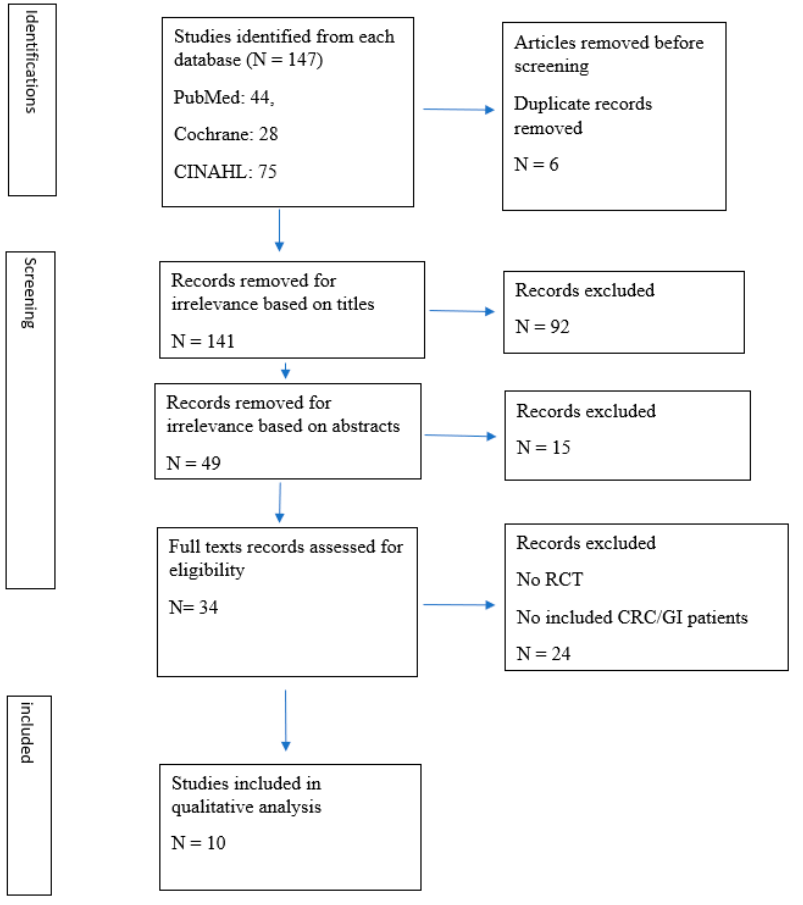
Figure 1. Prisma Flow Chart—Identification of Studies via Databases .